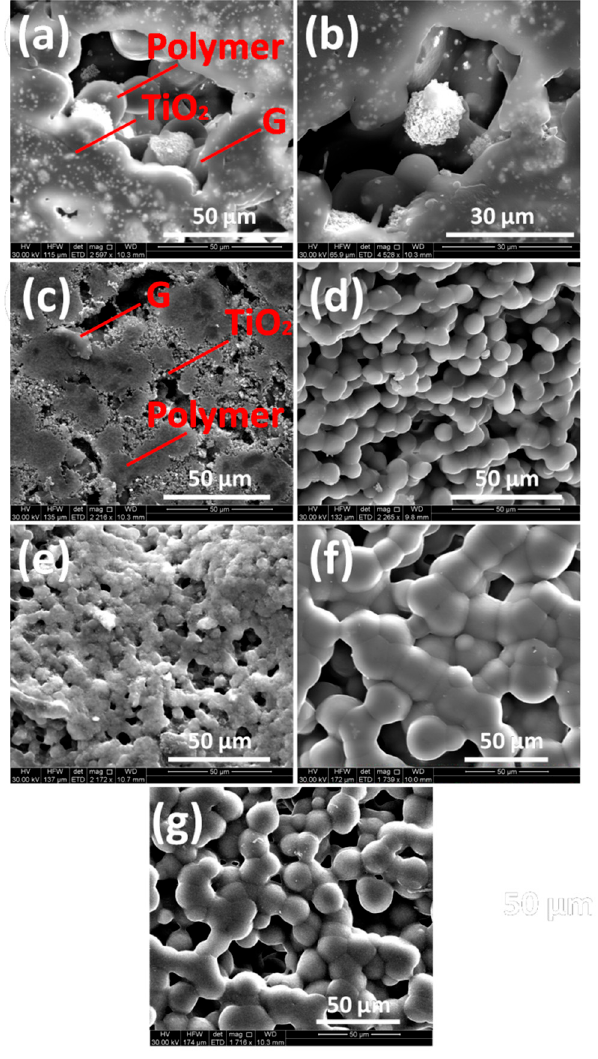
Figure 2. FESEM images of ( a ) G1T10PVDF ( b ) G2T10PVDF ( c ) G3T10PVDF ( d ) G4T10PVDF ( e ) G5T10PVDF ( f ) G4T20PVDF ( g ) G4T30PVDF.